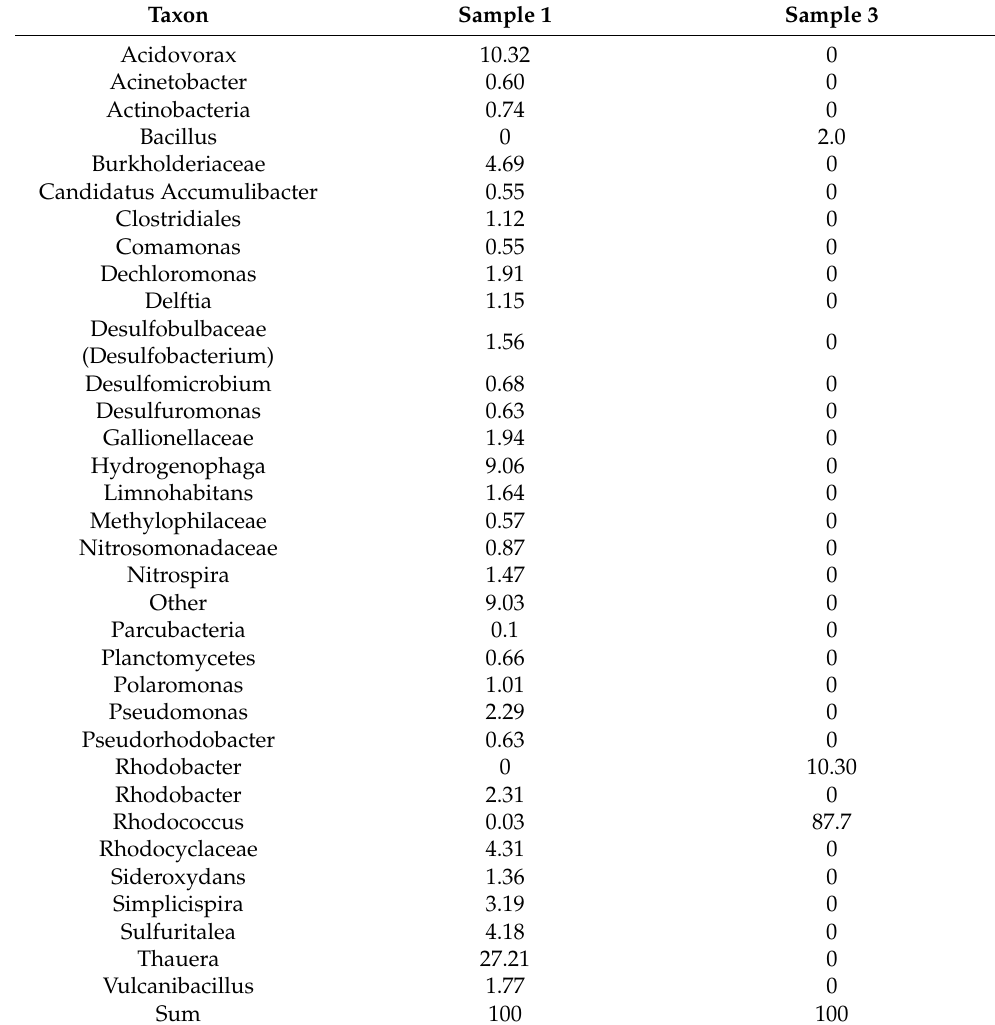
Table 5. Analysis of 16S rRNA genes of the microbial community in the samples with added whey (part 1). (% of the total number of